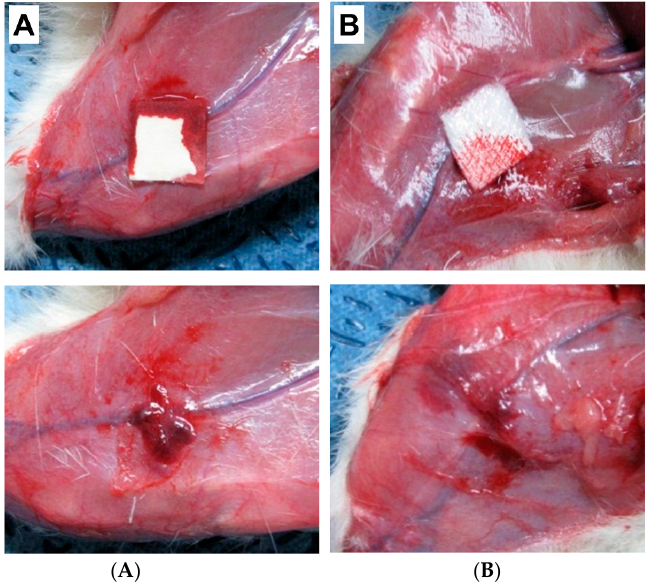
Figure 4. Evaluation of the hemostasis of the SF/Gel/PVA sponges using rat femoral hemorrhage in- jury model. Before removing hemostatic agents (upper panel) and after (lower panel). ( A ) ChitoClot ® , ( B ) SF/Gel/PVA [70].